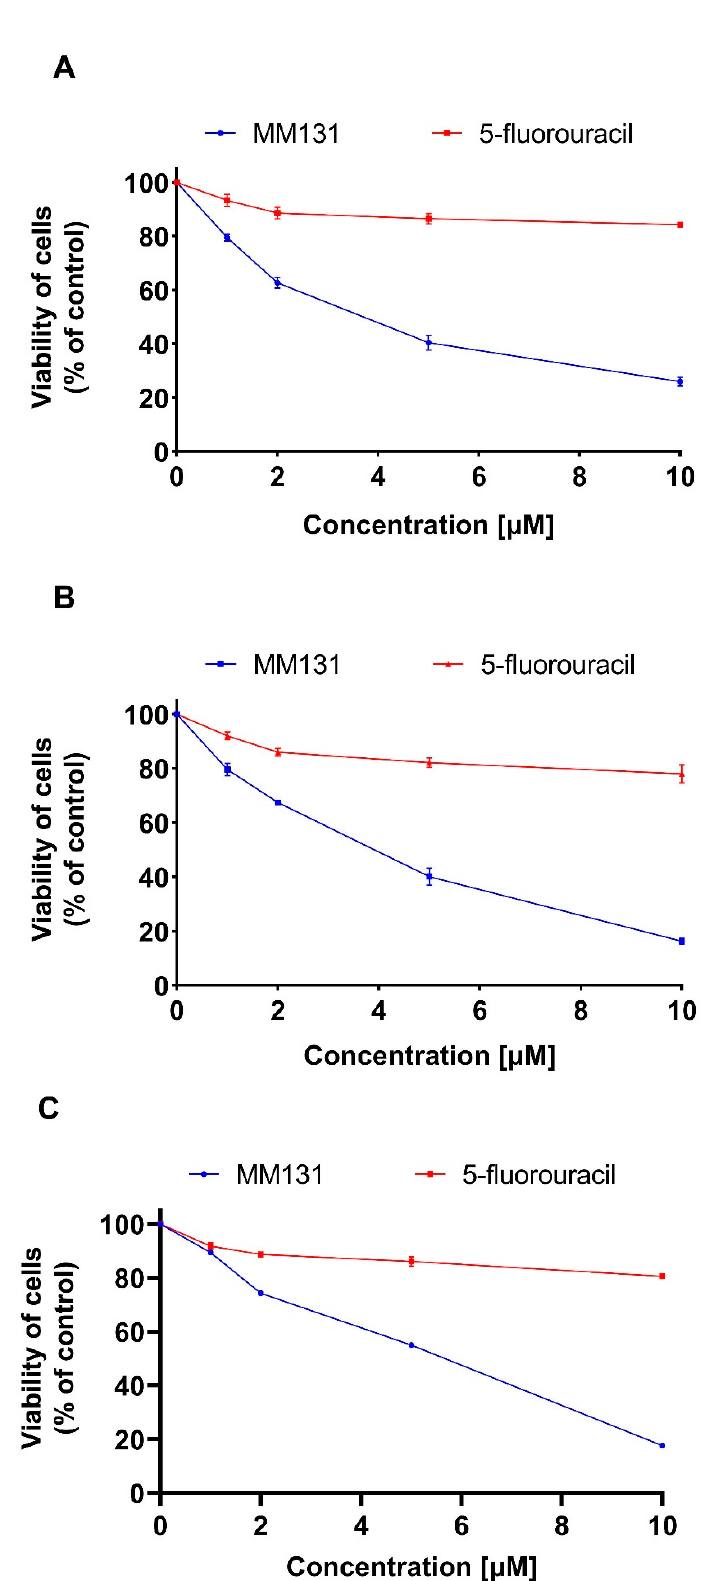
Figure 1. Cell viability was detected by MTT assay. The graph shows the cytotoxicity profile of MM131 and 5-fluorouracil against DLD-1 cells, ( A ) HT-29 cells, ( B ) and human skin fibroblasts; ( C ) at different concentrations (1–10 µM) at 24 h of incubation. The viability of colorectal cancer cells is represented as a percentage of untreated cells (± SEM, n = 3).